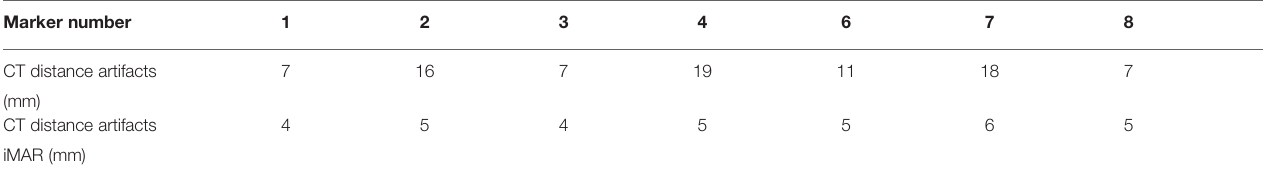
TABLE 4 | Distance from the fi ducial marker position, at which the streak artifacts become lower than 3% of the background level for 7 fi ducial markers ( Table 1 ), for the conventional treatment planning CT and the one with iMAR